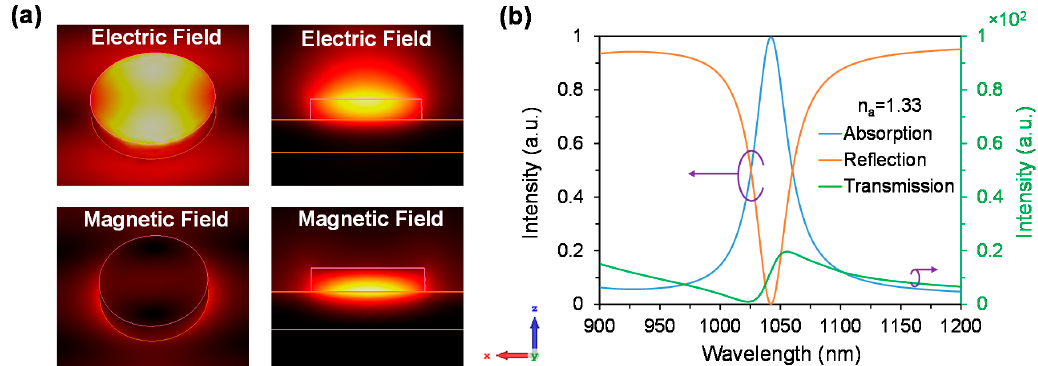
Figure 4. ( a ) Electric and magnetic fields distribution of the proposed metasurface absorber for n a = 1.33. The nanodisk parameters diameter is d = 300 nm; thickness, h = 50 nm and period, p = 670 nm, and ( b ) Absorption, reflection and transmission spectra of the proposed metasurface absorber at medium (n a = 1.33).